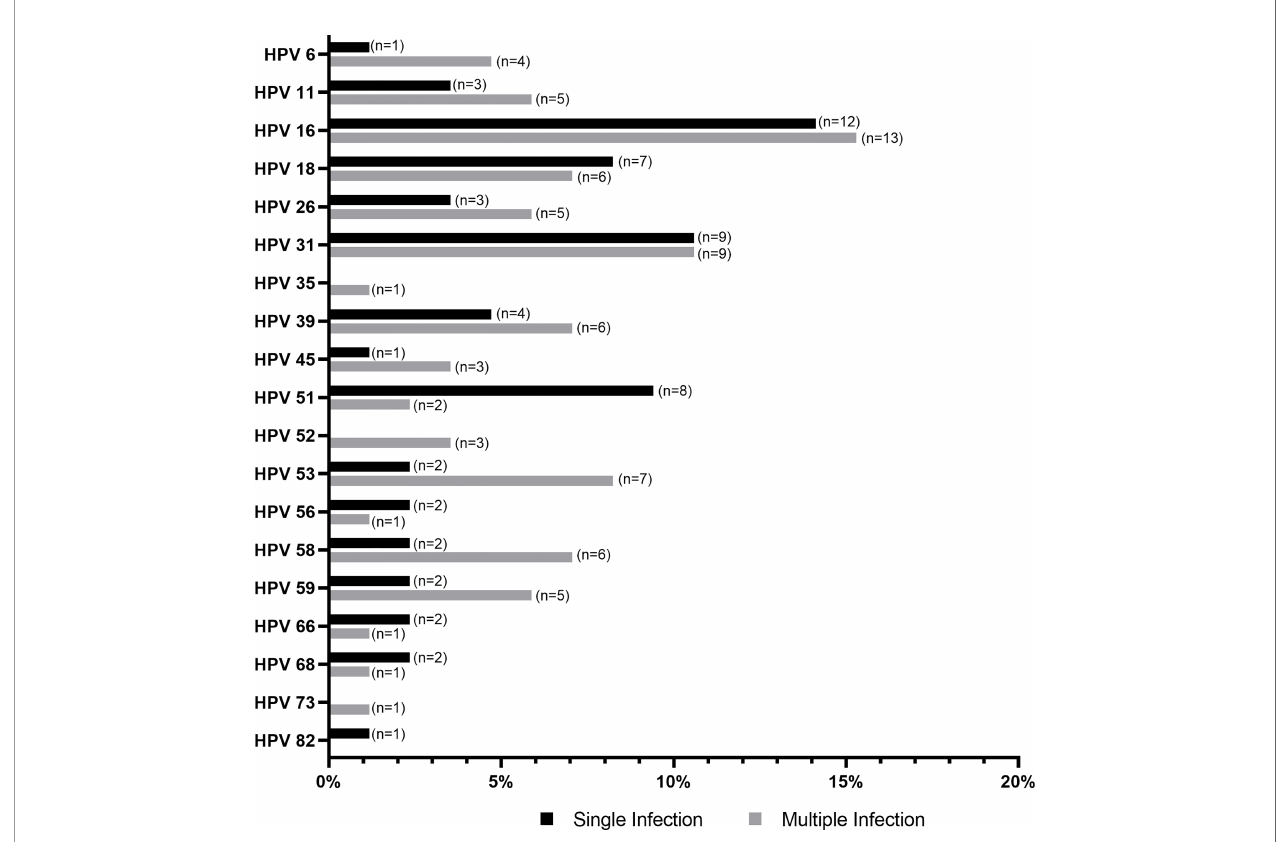
FIGURE 1 | Histogram showing the distribution of human papillomavirus (HPV) genotypes detected as single and multiple infection, relative to the total number HPV-positive samples